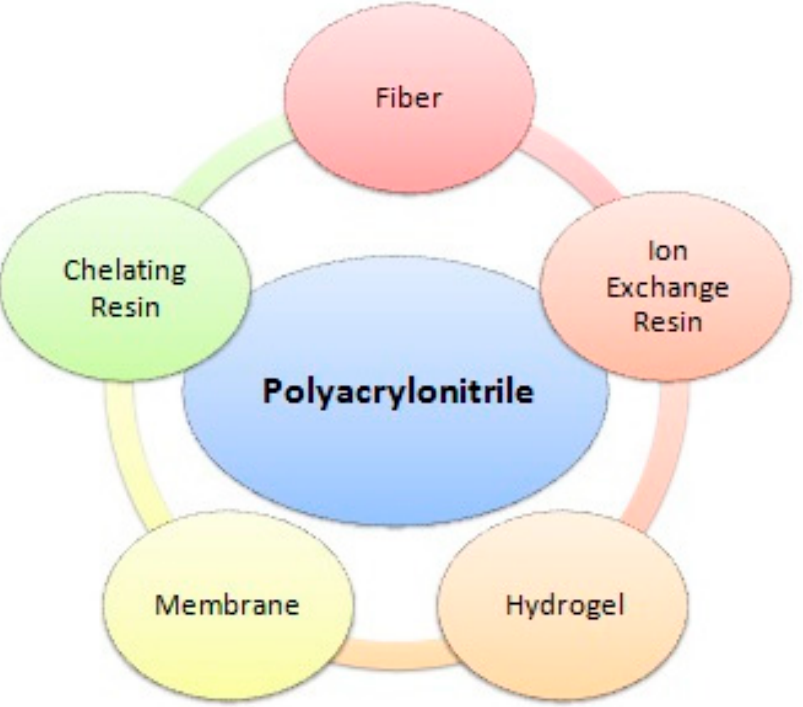
Figure 1. Use of polyacrylonitrile in different forms for extraction of metal ions.